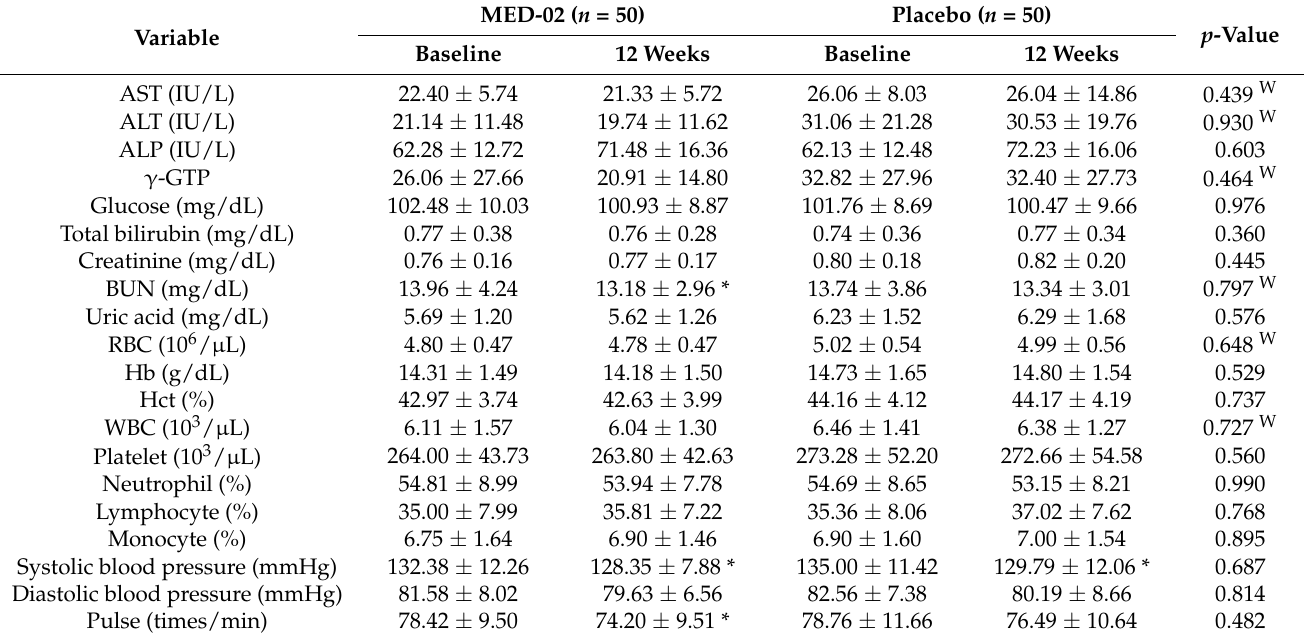
Table 3. Safety assessment of subjects before and after 12-week consumption of